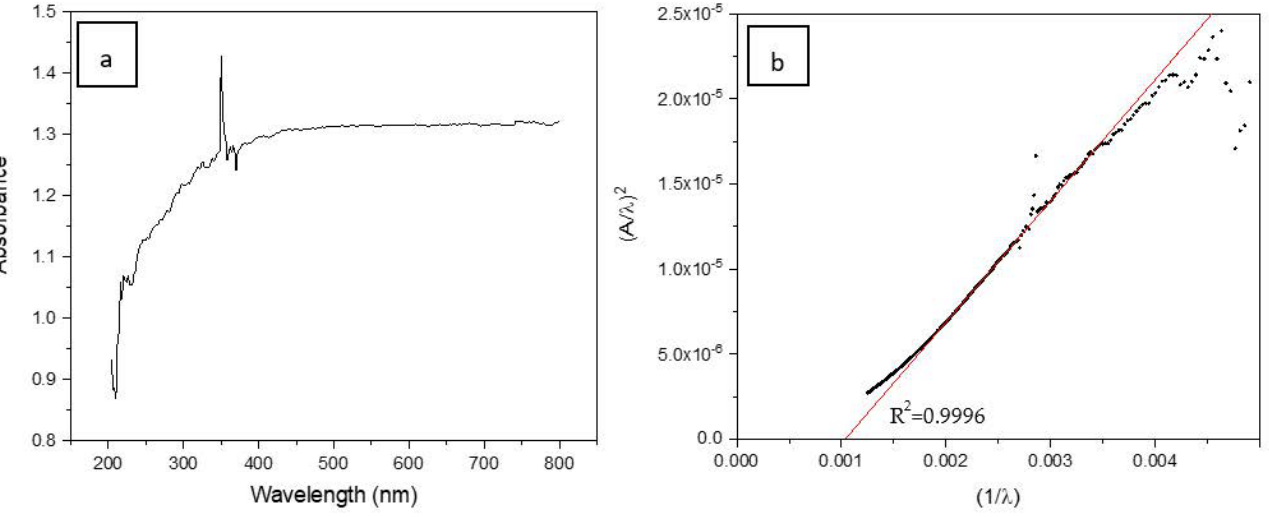
Figure 6. ( a ) Absorbance spectrum for SiC foam and ( b ) correlation (A /λ) 1/n vs. 1/λ (n = 1/2).